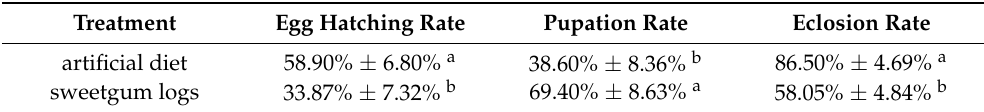
Figure 3. Differences in weight and length between males and females of Acanthotomicus suncei reared on the artificial diet and American sweetgum logs. Mean ± SD, ** p < 0.01. Table 3. Comparison of egg hatching rate, pupation rate, and eclosion rate of Acanthotomicus suncei reared on American sweetgum logs and the artificial diet.